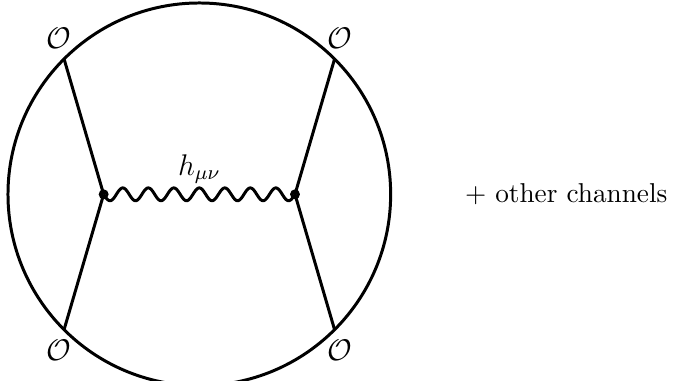
Figure 5 . The leading gravitational contribution to the Lorentzian correlator (4.1) comes from the Witten diagram with a single graviton